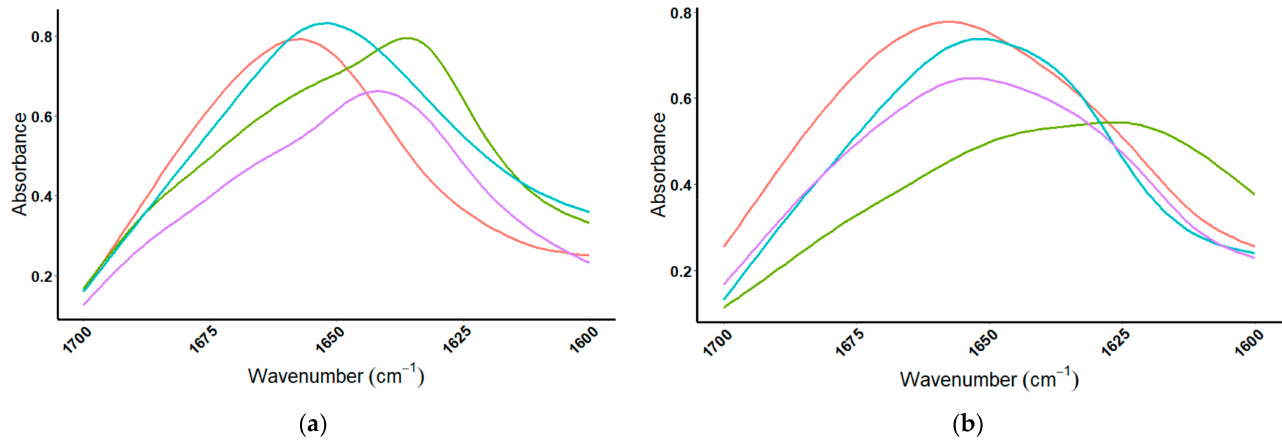
Figure 5. Amide I region (1700–1600 cm − 1 ) of MIR spectrum for the eight protein standards: ( a ) whey proteins: = β - lactoglobulin, = α -lactalbumin, = BSA, = IgG, and ( b ) non-whey proteins: = brown rice, = casein, = egg albumin, and = pea.